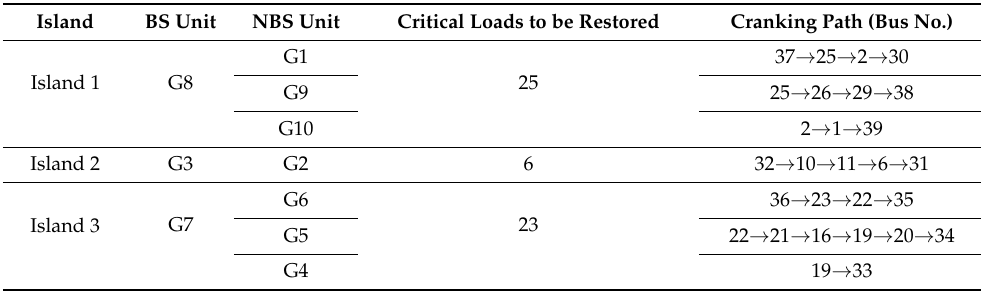
Figure 9. Optimal restoration path using the A* Algorithm for the IEEE-39 bus system. Table 8. Cranking paths from BS unit to NBS Table 7. Data generators for the IEEE-39 bus system and its classification.